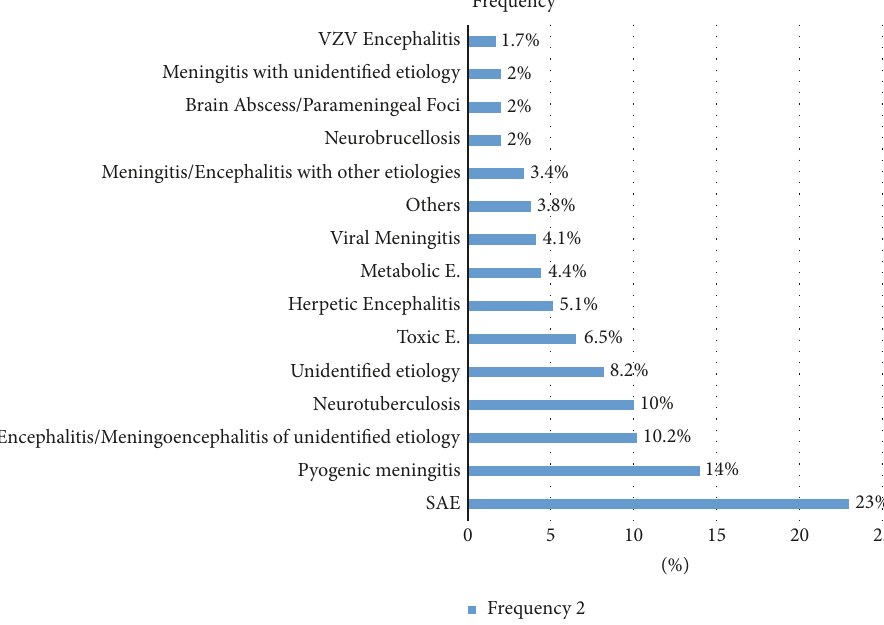
Figure 1: Final diagnosis of clinical syndromes suggestive of CNS infection. Metabolic E: Metabolic Encephalopathy; Toxic E: Toxic Encephalopathy; SAE: Sepsis Associated Encephalopathy; VZV: Varicella Zoster Virus